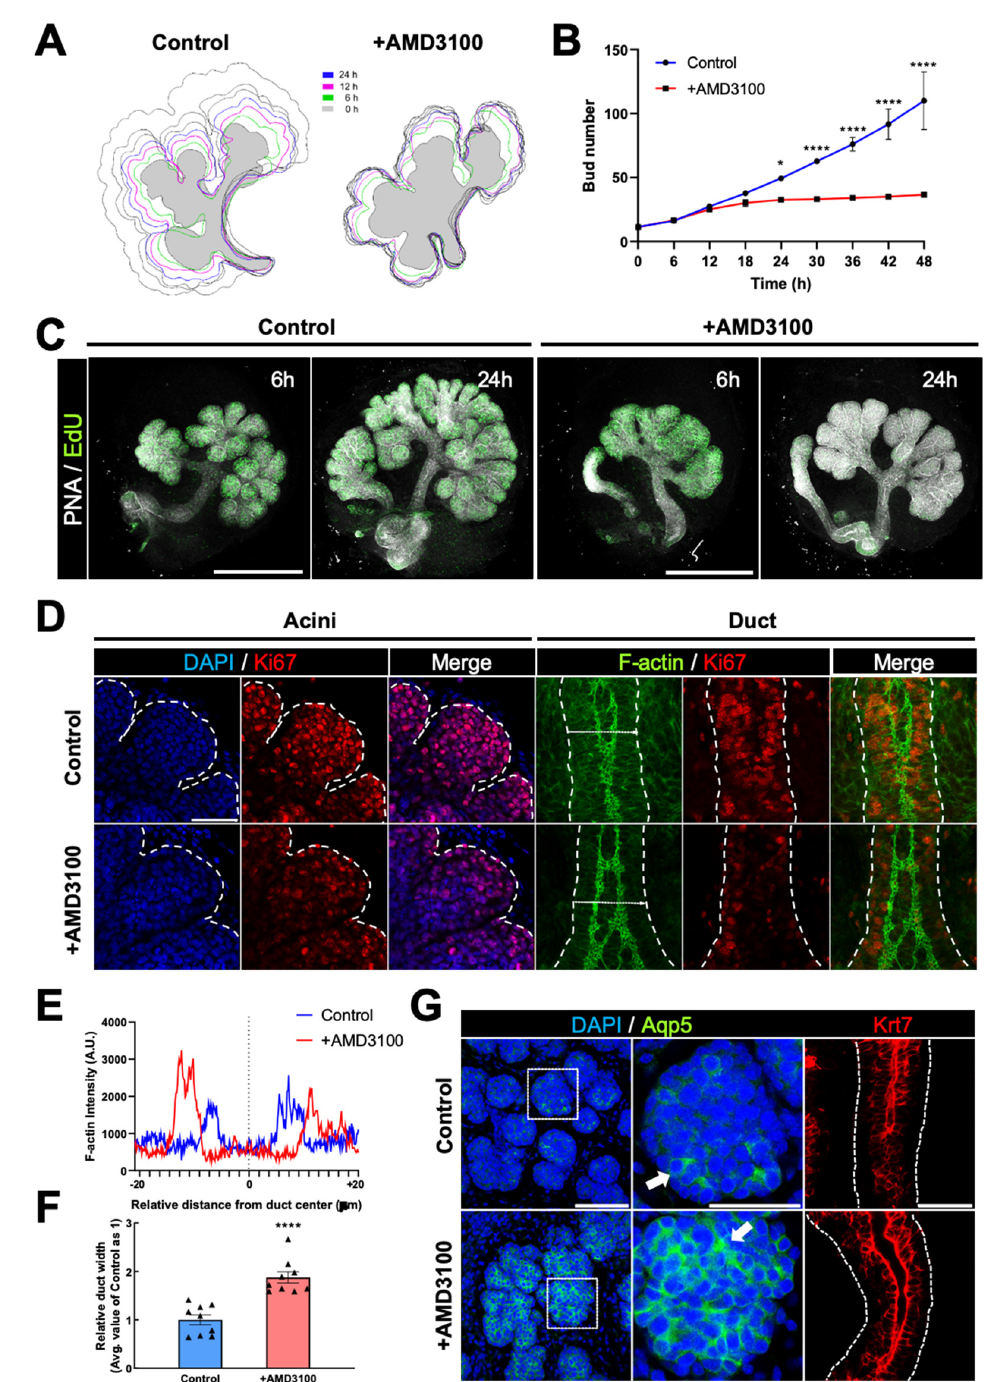
Figure 3. AMD3100-induced precocious differentiation of epithelial cells. ( A and B ) Representative contour tracing ( A ) and bud number changes ( B ) of control and AMD3100-treated eSMGs during 48 h at 6-h intervals ( n = 3). ( C ) EdU staining results at 6 and 24 h after AMD3100 treatment. EdU in green and PNA in gray ( n = 4, scale bar: 500 µ m). ( D ) Immunostaining results of Ki67 (red) and F-actin (green) in acini and duct of eSMGs 24 h after AMD3100 treatment. Morphologies of acinar buds and duct cells are outlined with white dotted lines. Scale bar: 50 µ m. ( E ) Duct widths of control and AMD3100-treated eSMGs were visualized via F-actin-based intensity profiles of horizontal sectioning of ducts 24 h after the treatment. ( F ) Duct widths of control and AMD3100-treated eSMGs were quantified 24 h after the treatment ( n = 9). ( G ) Immunostaining results of AQP5 (green) and KRT7 (red). Magnified regions of acinar buds are marked with white dotted squares. The white arrows (middle panels) indicate areas with the highest AQP5 expression ( n = 4, scale bar: left, 100 µ m; middle and right, 50 µ m). Data are presented as the mean ± SEM; * p < 0.05, **** p < 0.0001; t